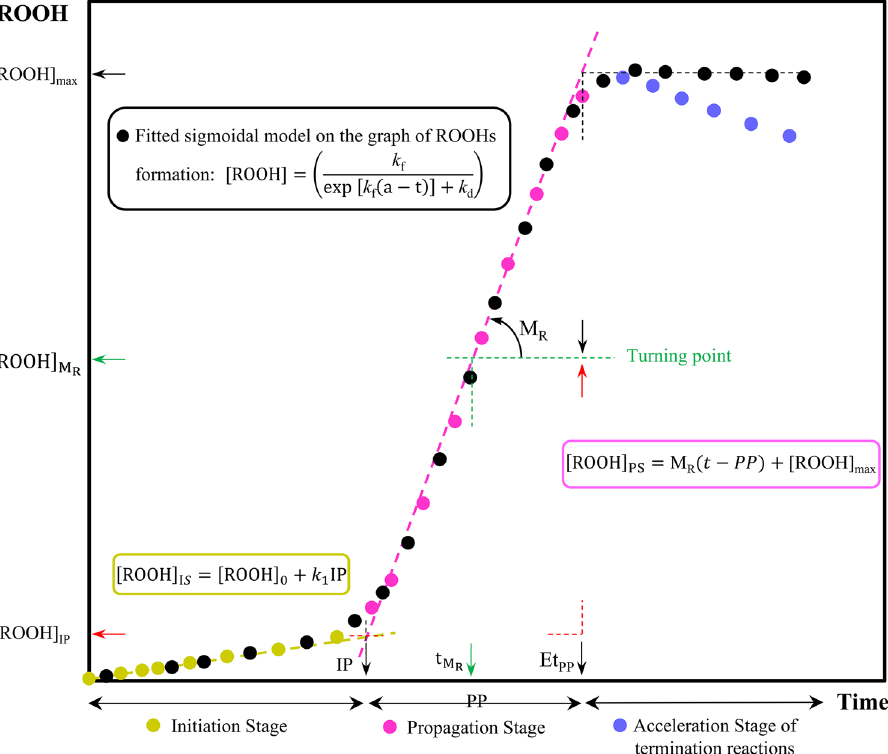
Figure 1. Schematic curve of hydroperoxides (ROOHs) production and a guide of calculated kinetic points. Et PP end time of the termination phase, IP induction period, k f rate constant of ROOHs formation at the propagation phase, k d rate constant of ROOHs decomposition at the propagation phase, k 1 rate constant of the initiation phase, M R maximum rate of ROOHs formation in the propagation phase, PP propagation period, ROOH ROOHs concentration, [ROOH] IP ROOHs concentration at IP point, [ROOH] max maximum concentration of produced ROOHs, [ ROOH ] M R ROOHs concentration at the point of the maximum rate of ROOHs formation (or turning point), t M R occurrence time of maximum rate of ROOHs formation (or turning